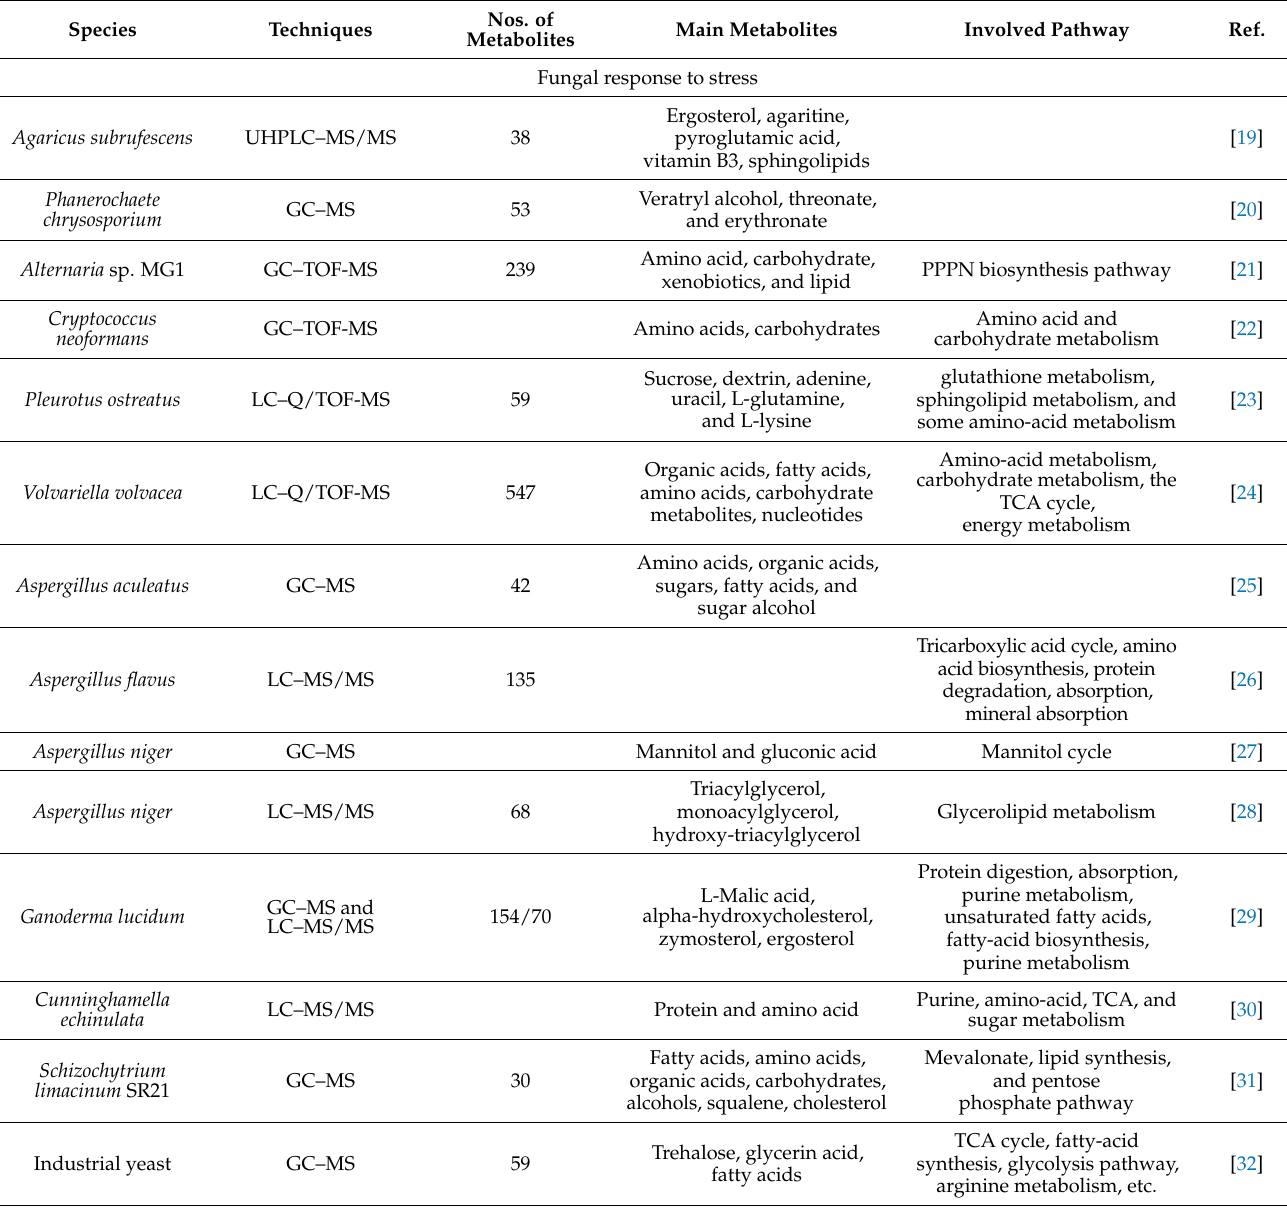
Table 1. Application of metabolomics in fungal research in recent